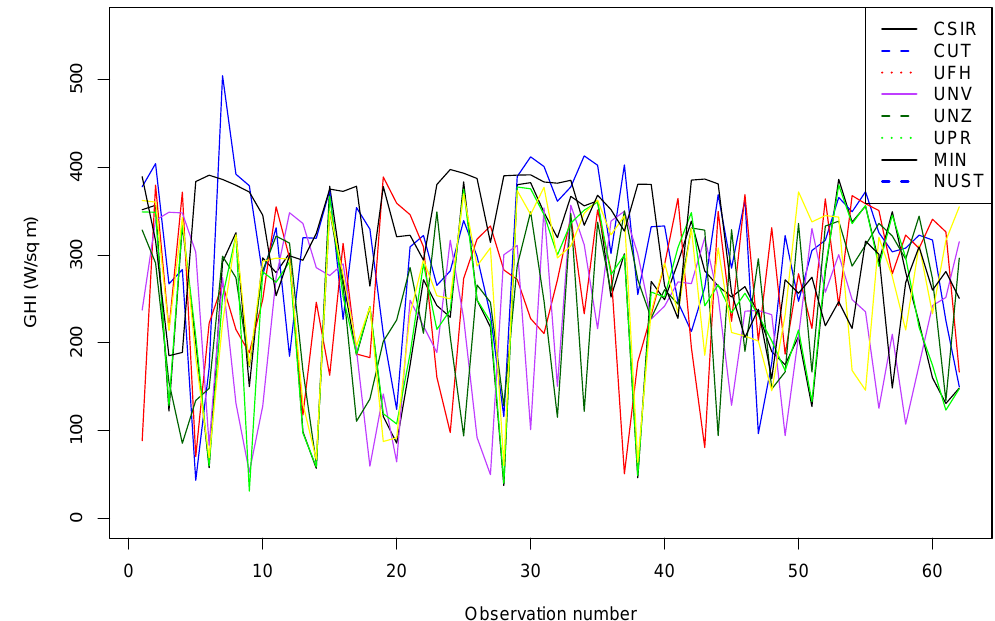
Figure 4. Time series plot of the GHI data at the eight radiometric